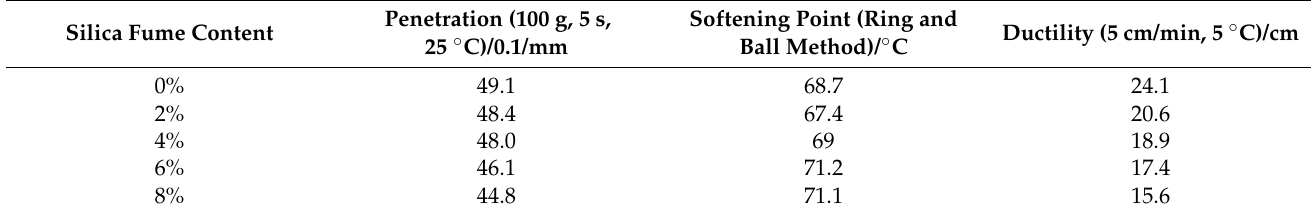
Table 4. Three major indices of the silica fume/ styrene-butadiene-styrene composite-modified asphalt with different silica fume contents after